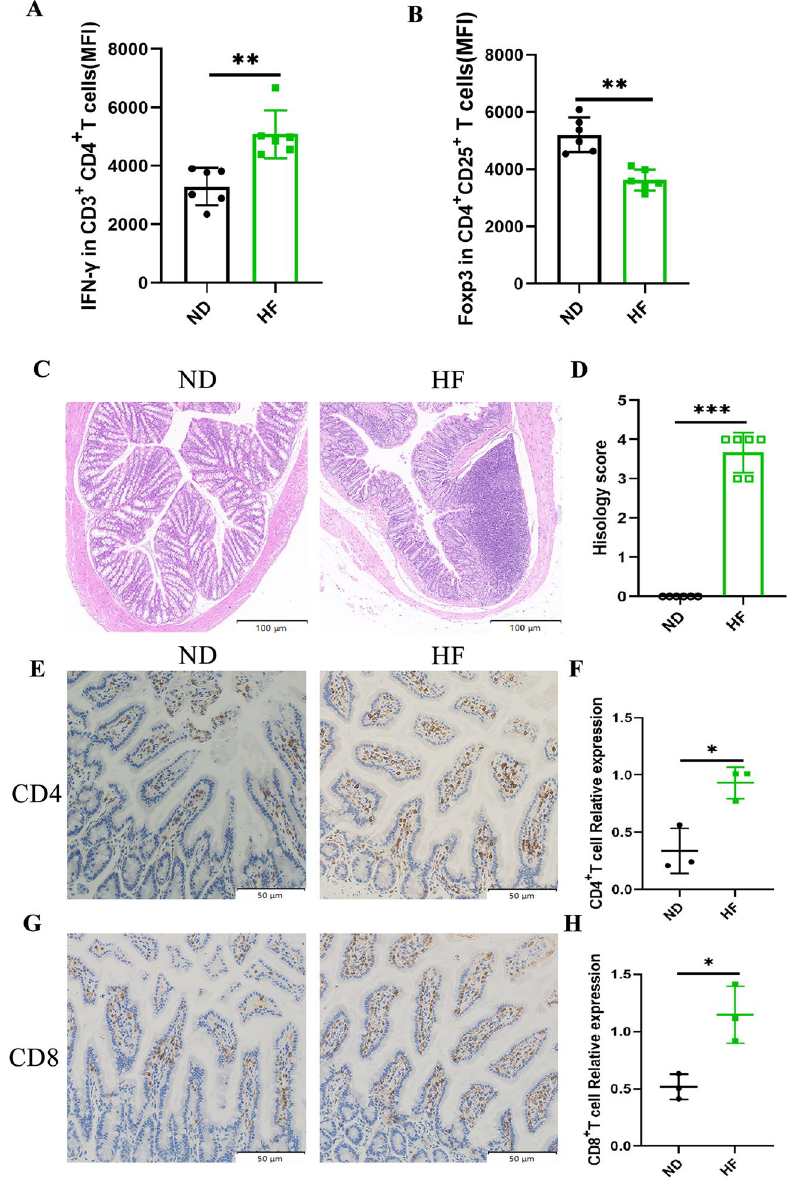
Figure 6. HF diet causes gut inflammation. We gated on mesenteric lymph nodes lymphocytes at 4 weeks and measured the MFI expression level of IFN-γ ( A ) in CD3 + CD4 + T cells and Foxp3 ( B ) in Treg cells (CD25 + Foxp3 + ) by flow cytometry. Colon tissues were examined histologically after ( C ) H&E staining and ( D ) scored for inflammation and epithelial injury. Bar: 100 µm. Immunohistochemistry for 4-week jejunums, with primary antibodies against ( E ) CD4 and ( G ) CD8. Bar: 50 µm. Quantification of ( F ) CD4 + and ( H ) CD8 + T cells. The student’s t-test was used to determine statistical significance. * p < 0.05; ** p < 0.01, *** p <